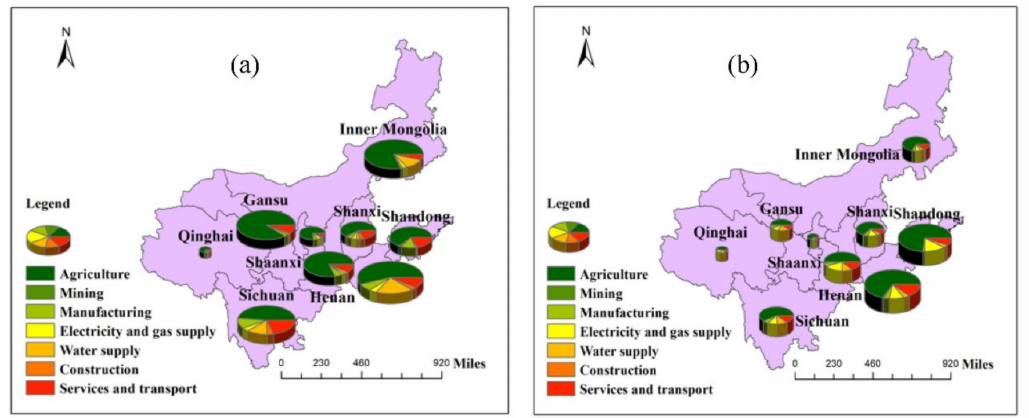
Figure 4. Trade structure of virtual water (%): ( a ) indicates the percentage of industrial sector output; and ( b ) indicates the percentage of industrial sector input.